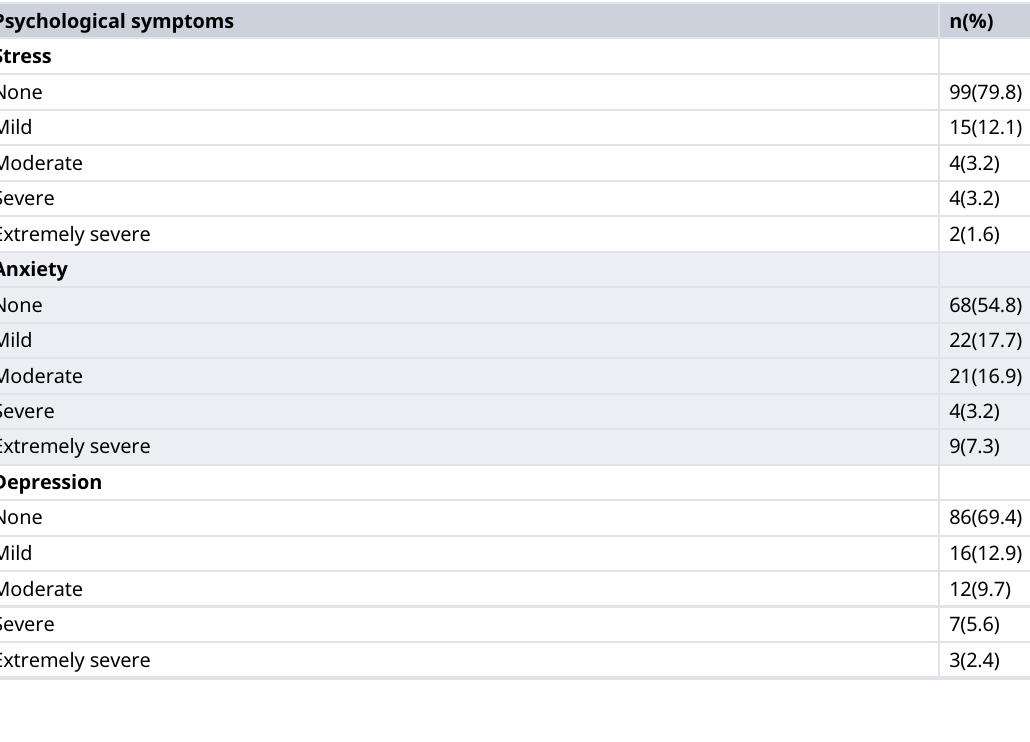
Table 3. Presence and absence of psychological symptoms in schoolteachers.